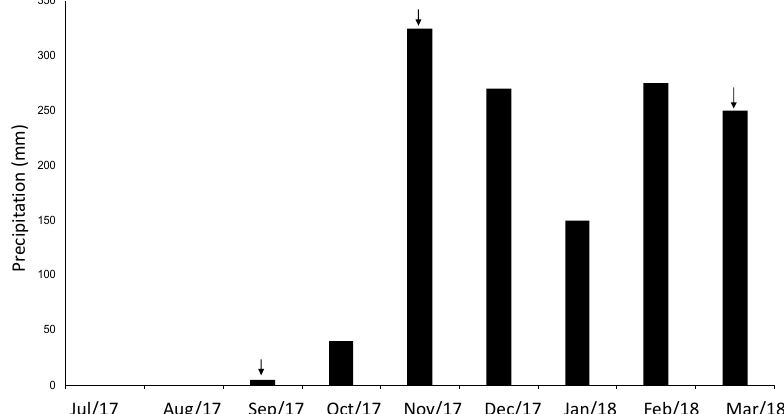
Figure 2. Monthly precipitation data from the Brazilian National Meteorology Institute from July 2017 to March 2018 in Brasilia. Arrows indicate the months in which soil was collected: the dry season in September 2017, transition in November 2017, and late rainy season in March 2018.